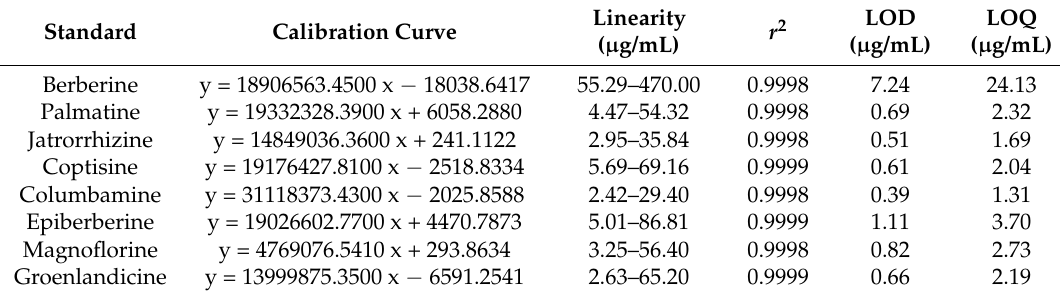
Table 1. Levels of alkaloid compounds in rhizomes originated from four Coptis